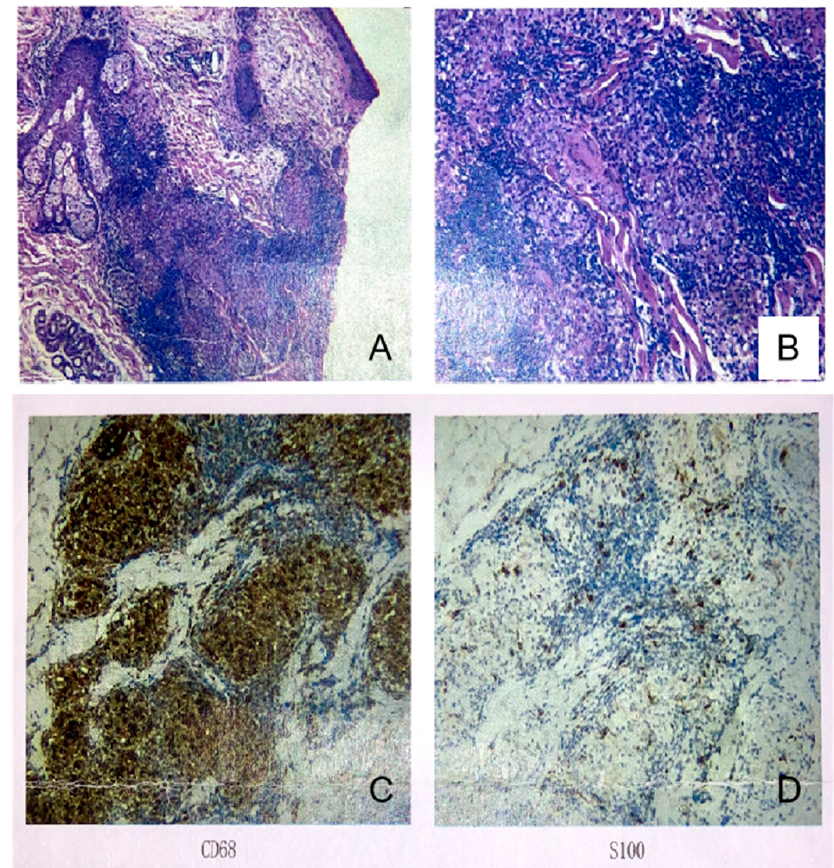
Figure 2. Left inside canthus skin biopsy stained with HE. ( A ) Atrophy and thinning of the epidermis. ( B ) Histiocytic proliferation and multiple nodules surrounded by scattered lymphocytic infiltration in the dermis. Histiocytes negative for CD1a, positive for ( C ) CD68, and scattered positive for ( D ) S100. Her routine laboratory tests of complete blood count, renal and hepatic function, erythrocyte sedimentation rate (ESR), C-reactive protein (CRP) immunoglobulin and com- plement level were normal. Autoantibody spectrum showed that ANA (1:160),